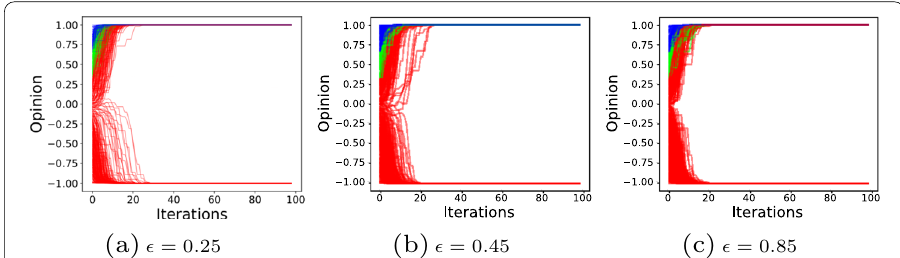
Fig. 3 Opinion evolution varying ǫ for WHK G . The system reaches a polarization equilibrium and the final status is independent by the ǫ value. Such a parameter only affects the convergence speed, making it quicker as it